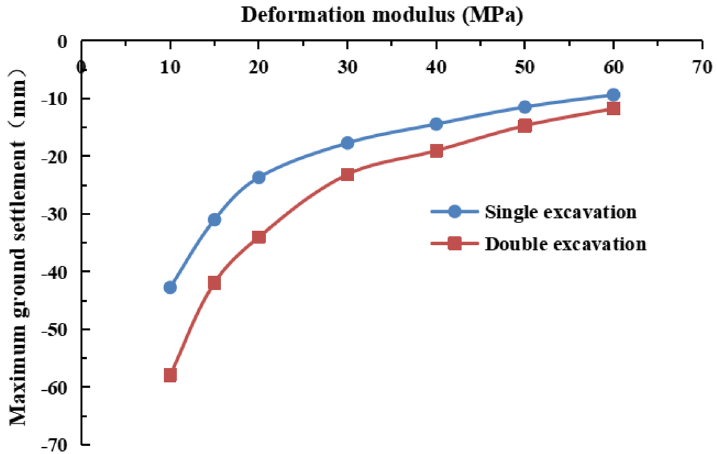
Figure 18. The maximum surface settlement during single-line and double-line excavation for different deformation modulus values.